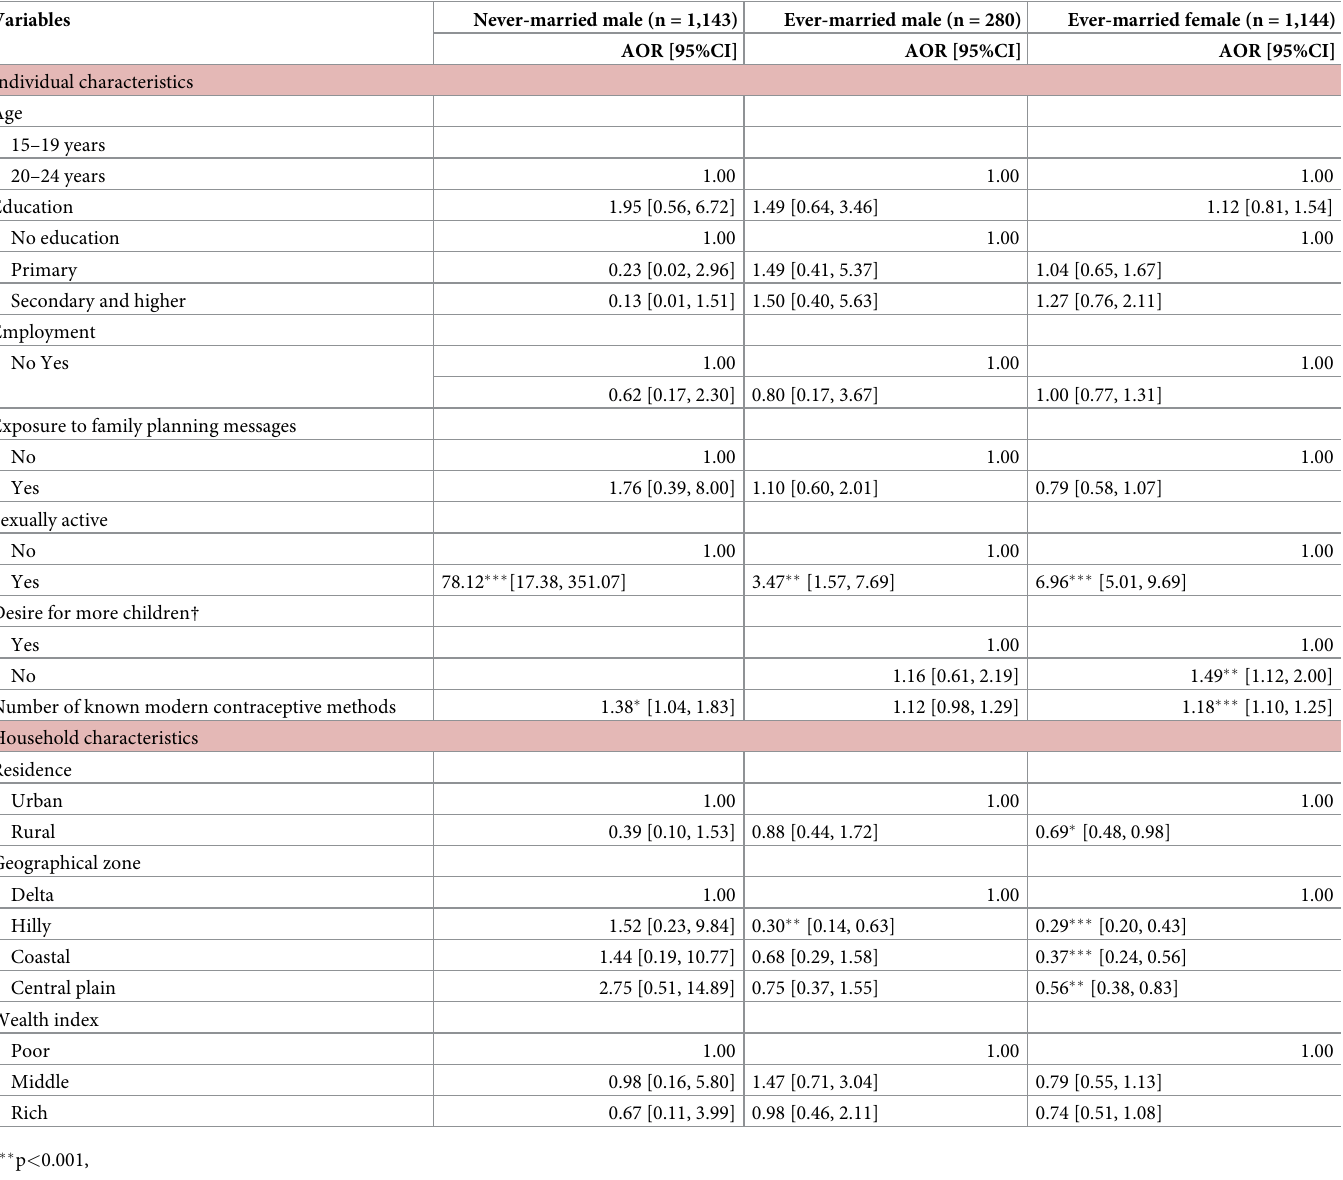
Table 5. Multivariable binary logistic regression analysis of modern contraceptive methods utilization among never-married male, ever-married male and ever- married female youth in Myanmar.